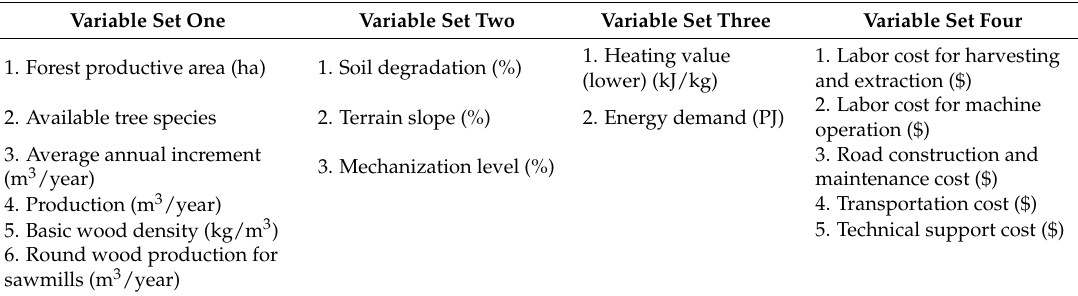
Table 11. Variable sets of research